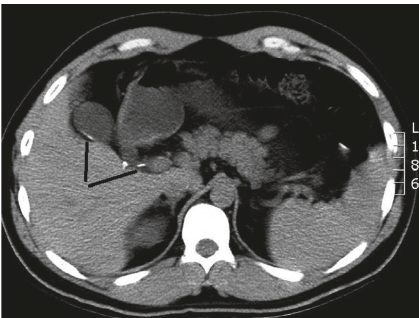
Figure 1: CT abdomen: linear calcification extending from the gallbladder through the cystic duct (dashes).